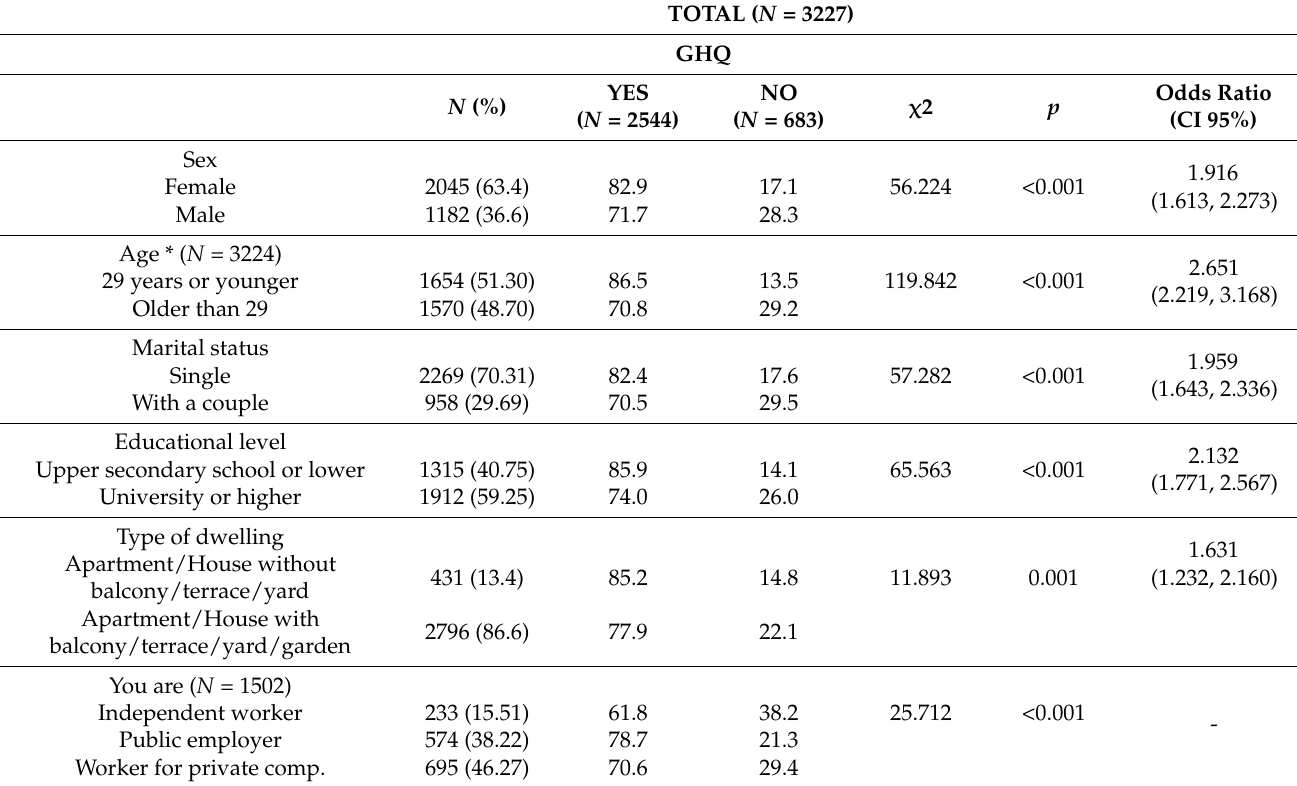
Table 1. Association between sociodemographic variables and psychological distress during the COVID-19